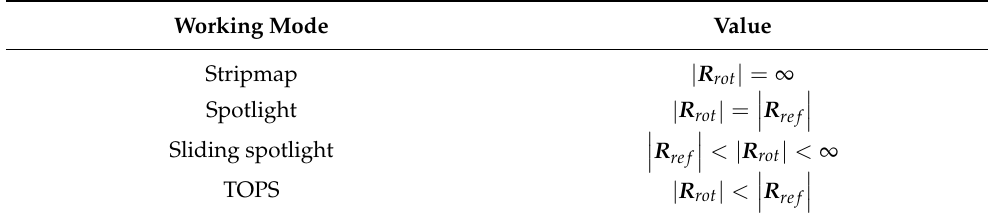
Table 3. Values of | R rot | for different working